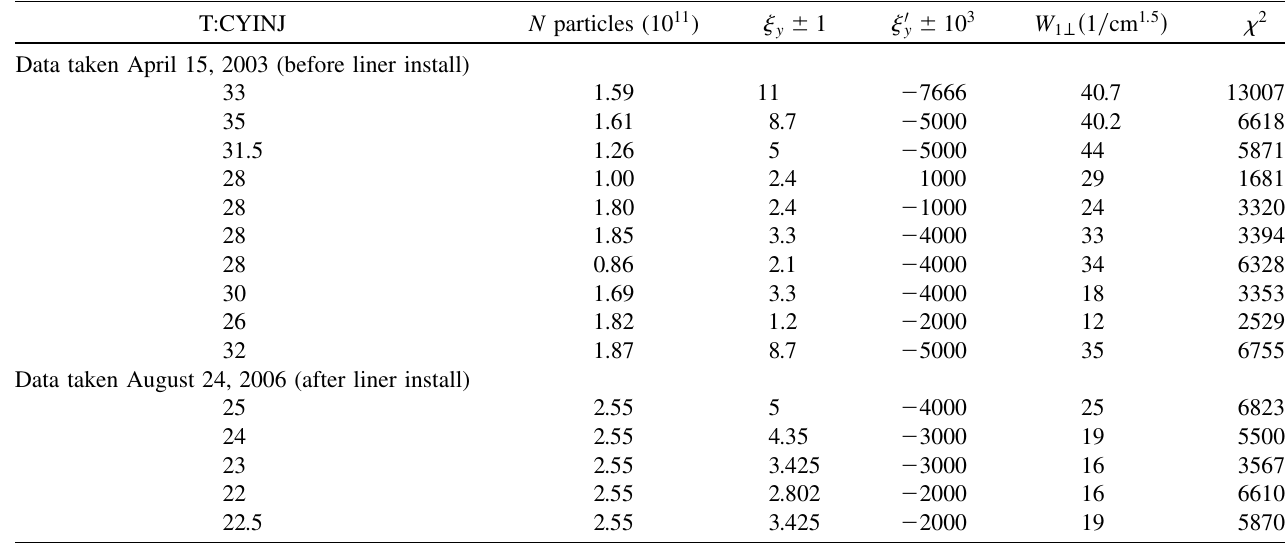
TABLE II. Vertical fits to turn-by-turn